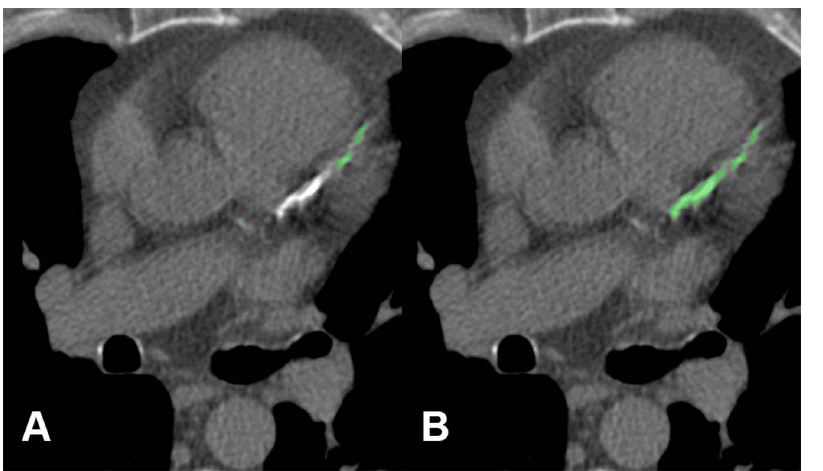
Figure 2. False negative by automated scoring. Example of an ‘outlier’ by automated quantification (A) compared to reference (B). In the LAD a severe calcification and black voids are visible. No stent was present.